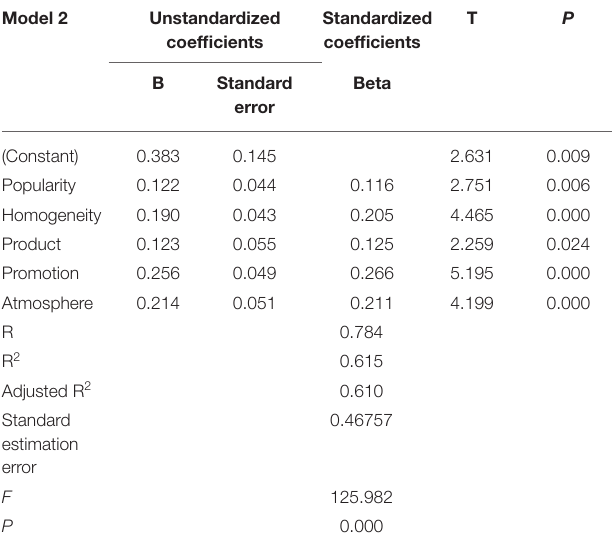
TABLE 10 | Model 2 regression coefficients and goodness-of-fit